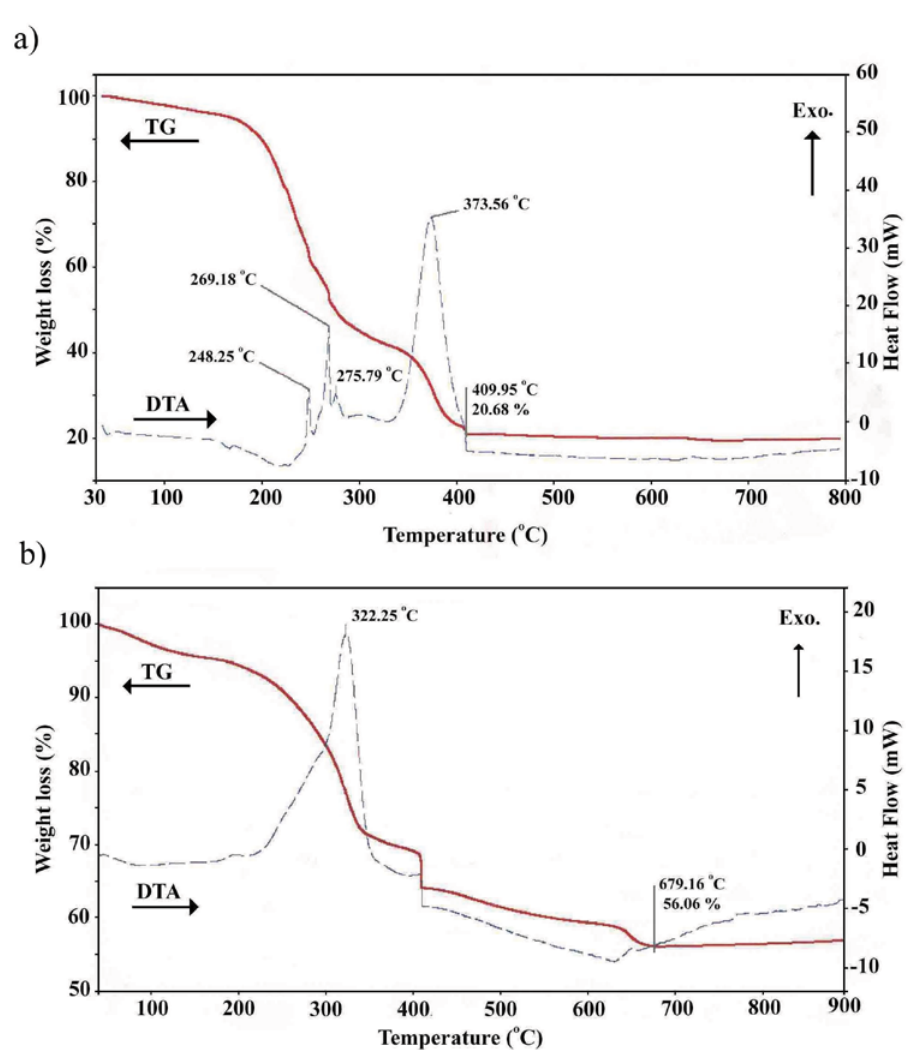
Figure 1. TG and DTA cures of citrate precursors, a) P